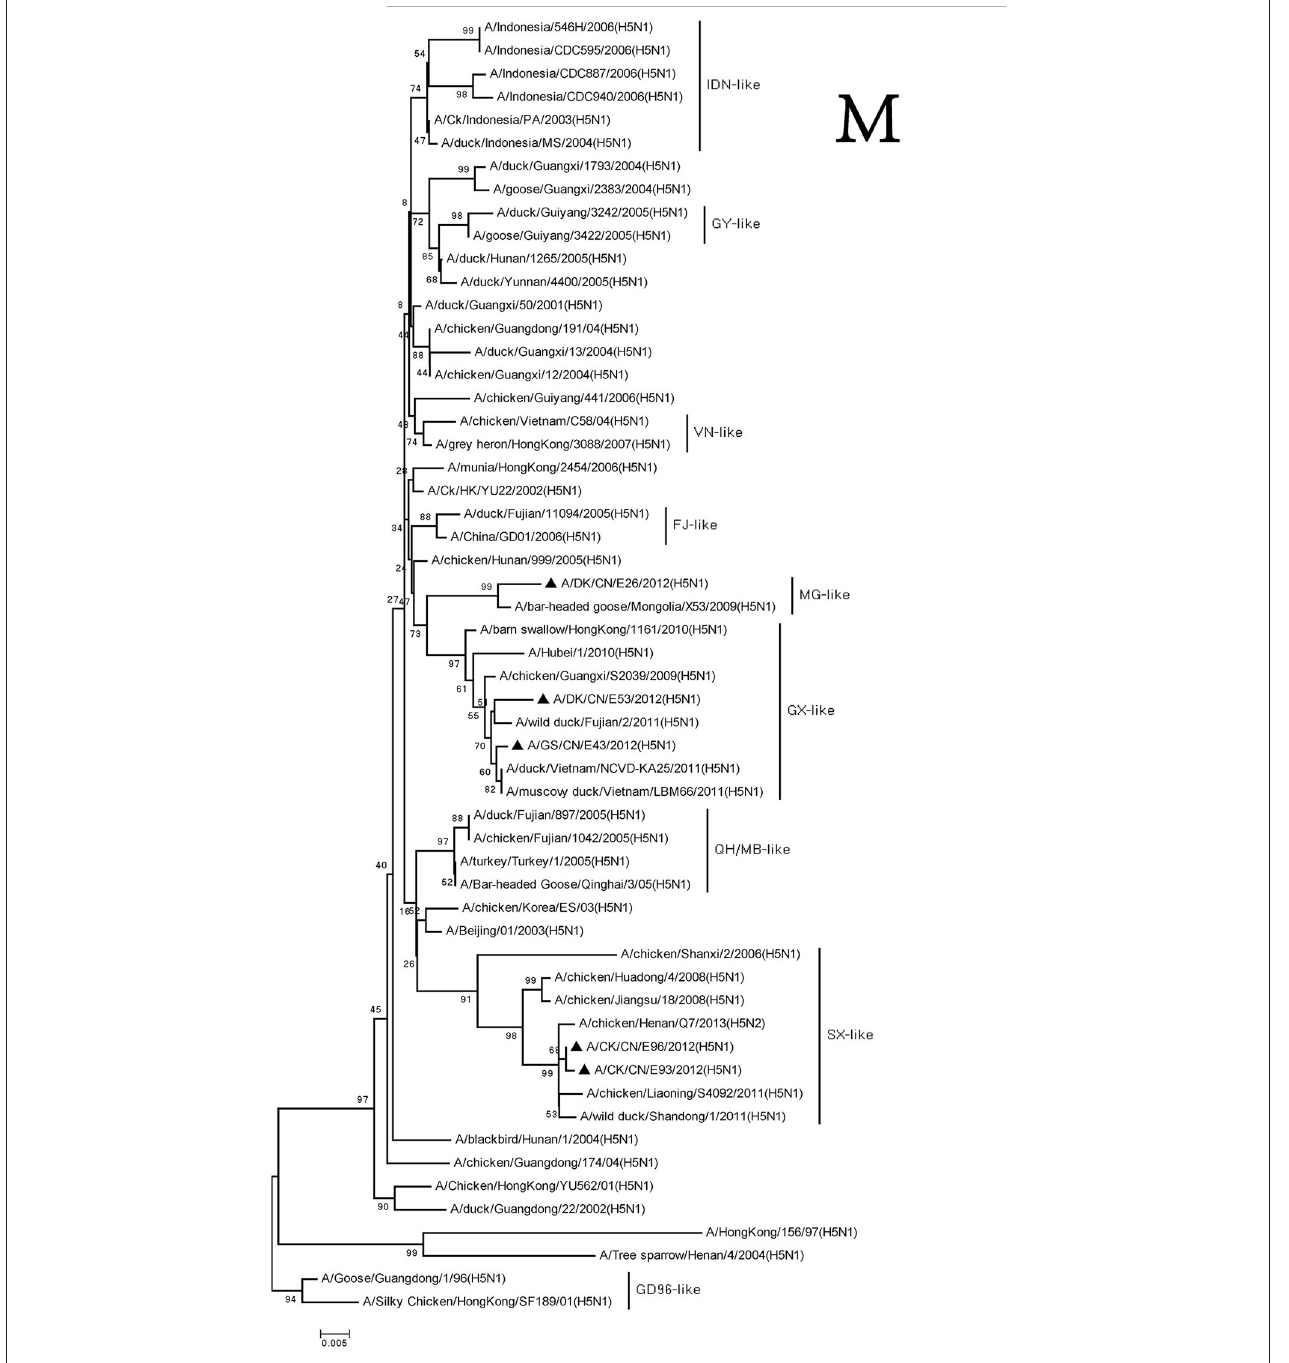
FIGURE 7 | Phylogenetic analysis of M. M: nt26–795. Except our isolate, other virus sequences were downloaded from GenBank. QH, Qinghai; VN, Vietnam; IDN, Indonesia; GY, Guiyang; MG, Mongolia; GX, Guangxi; HD, Huadong; SX, Shanxi.